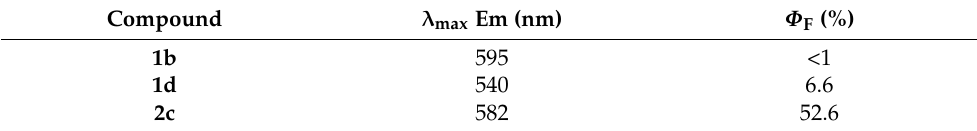
Figure 3. Fluorescence spectra in the solid-state of compounds 1b , d , and 2c (at 25 ◦ C). Table 3. Photophysical properties of compounds 1b , d , and 2c in the